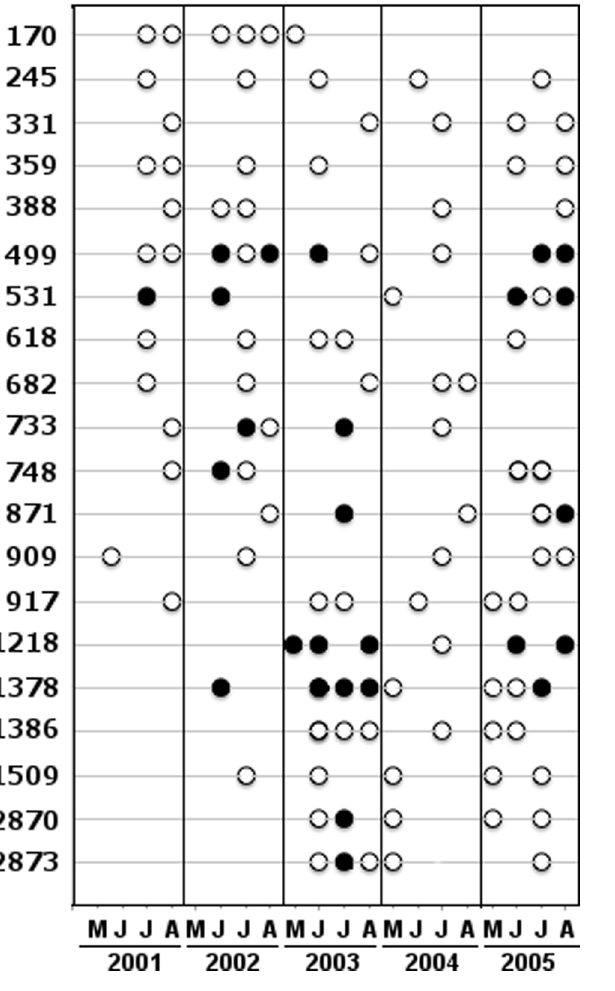
Figure 2. Examples of temporal variability in RVNA serological status of 20 wild big brown bats ( Eptesicusfuscus ) sampled 5 or more times, Fort Collins, Colorado 2001–2005. Open circles denote seronegative, closed circles denote seropositive at date shown at the bottom of the figure (vertical lines separate years). M-A are months of May through August each year. Individual bat identification number is given at the left-hand column.